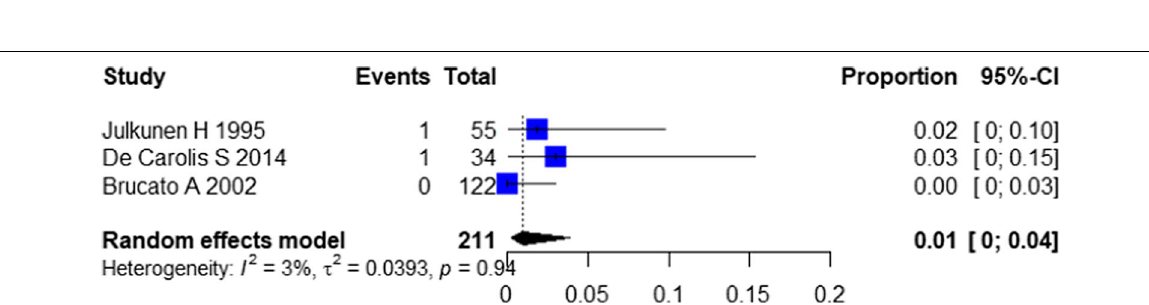
Fig. 7 Meta‑analysis of the incidence of intrauterine growth retardation in fetuses of women with Sjogren’s syndrome or rheumatic diseases with reactive anti‑SSA/Ro antibodies